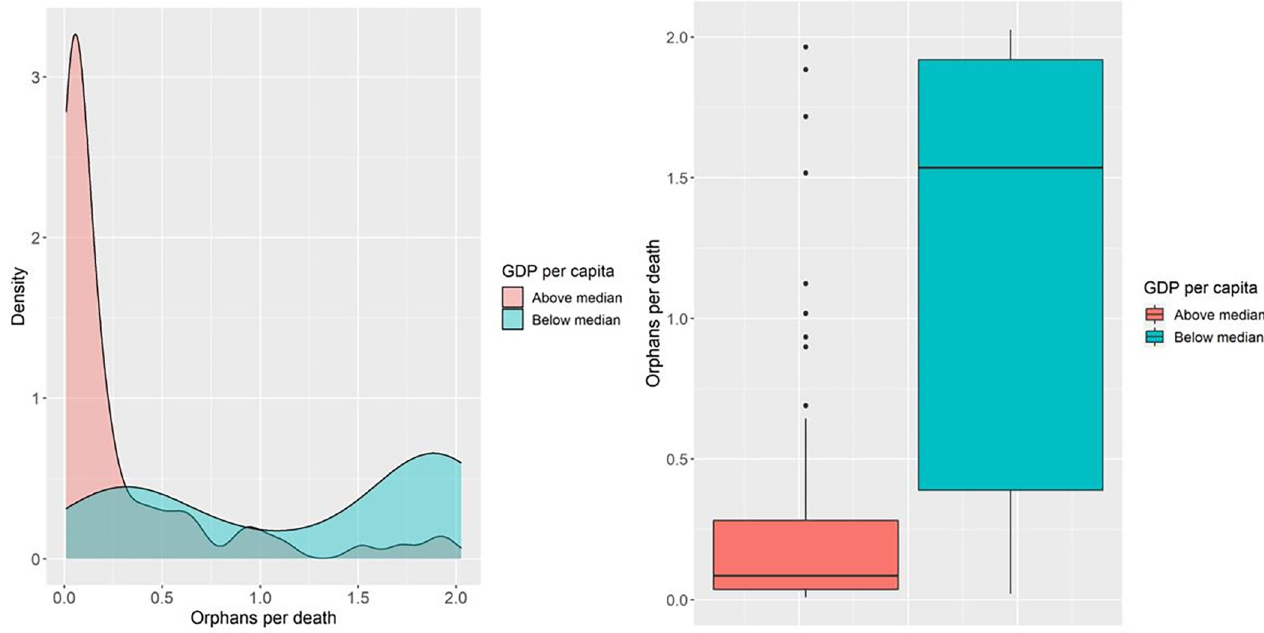
Fig 2. Kernel density functions for OPD by GDP category (Left) and boxplots of OPD by GDP category (right). GDP categories calculated as countries with a GDP below the median value in the study data, and those countries with a GDP above the median value. Median value = US $12,939 per capita.